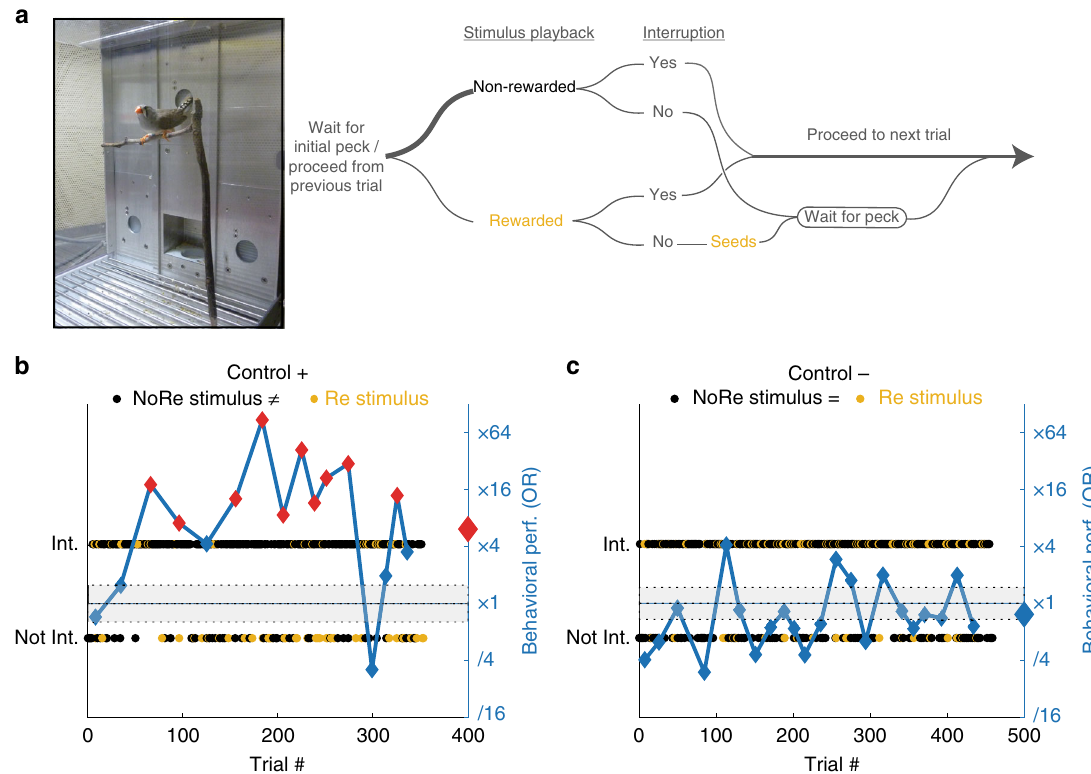
Fig. 1 Operant conditioning task used for quantifying bird discrimination of vocalizer identity. a Bird testing chamber and sequence of events in one trial. Birds learn to peck a keypad to initiate the playback of 6 s sequences of vocalizations from one of two vocalizers. One of the vocalizer is associated with a reward (Re vocalizer) while the other vocalizer is not (NoRe). Twenty percent of trials trigger vocalizations from the Re vocalizer and 80% trigger vocalizations from the NoRe vocalizer. At any time, even during playback, a peck on the keypad triggers a new trial. Interrupting an Re stimulus systematically cancel the access to the reward. Birds maximize their food access by interrupting the NoRe vocalizer and by refraining from interrupting the Re vocalizer (Supplementary Movie 1). b Schematic of a subject performing the task. The bird quickly identi fi es the vocalizers and, accordingly, interrupts more the NoRe vocalizer stimuli (black dots aligned with interrupted (Int.)) than the Re vocalizer stimuli (yellow dots aligned with not-interrupted (Not- Int.)). The behavioral performance is measured by the odds ratio (OR) of interrupting the NoRe over the Re. OR is calculated at successive time windows (blue line) or over the entire test (large diamond on right y -axis). The right y -axis uses a logarithmic scale: ‘ x2 ’ means NoRe vocalizations are twice more likely to be interrupted than Re vocalizations. Red diamonds indicate an OR value signi fi cantly different from 1. The gray area depicts the 5 − 95% quantiles for a random odds ratio for all trials. While locally the OR might not be signi fi cant (little blue diamond) although it is above the con fi dence interval for random interruption, these points contribute to the signi fi cance over the entire test (big red diamond). c Schematic of a subject in the control condition. This targeted interruption behavior is not observed when the two sets of vocalizations are identical and the reward is randomly assigned to the two